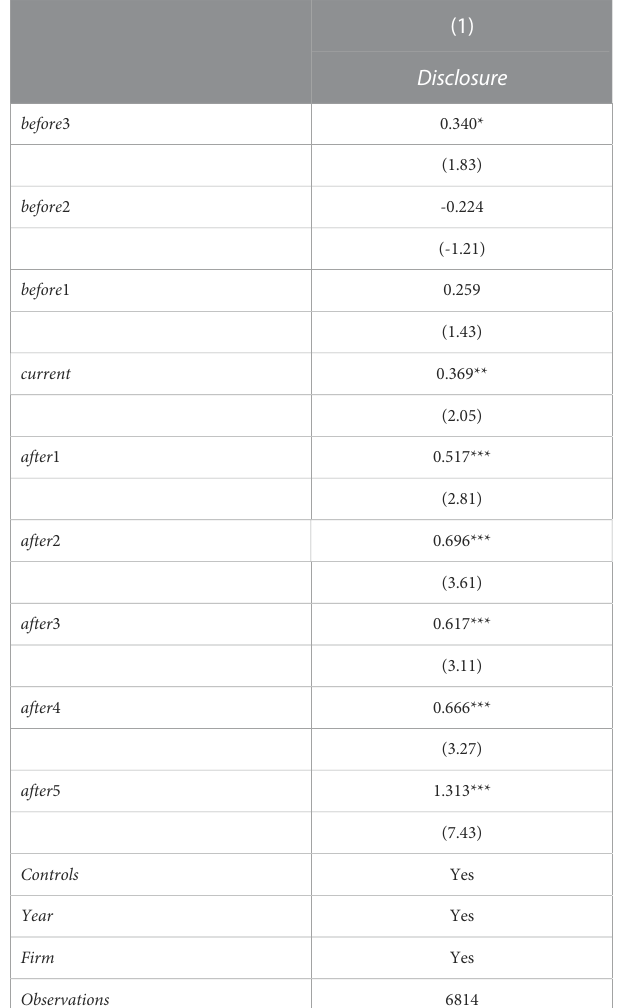
TABLE 9 The Dynamic Impact of Capital Market Liberalization on the ESG Disclosure: This table shows the dynamic impact of capital market liberalization on the ESG disclosure. We consider a 9-year window spanning from 3 years before deregulation until 5 years after deregulation. The dependent variable Disclosure is a total score for the fi rm-level ESG disclosure. The beforej equalsonefor fi rmsinthe j thyearbeforeenteringthelistoftarget stocks, while afterj equals one for fi rms in the j th year after entering the list of target stocks, and 0 otherwise. current equals one for fi rms entering the stock list in the year of liberalization policy implementation. Controls represents all the control variables including fi rm size ( Size ), return on total assets ( ROA ), fi nancial leverage ( LEV ), growth rate ( Growth ), ownership concentration ( Top 1), integration of two positions ( Dual ), board size ( BoardSize ), ratio of independent directors ( Independent ), top three executives ’ compensation ( Salary ), and management shareholding ratio ( ManageHold ). Year fi xed effects( Year )and fi rm fi xedeffects( Firm ) arebothincluded.RefertoTable1for detailed variable de fi nitions. t -statistics are reported in parentheses.***, ** and * denote signi fi cance levels at 1%, 5% and 10%, respectively.